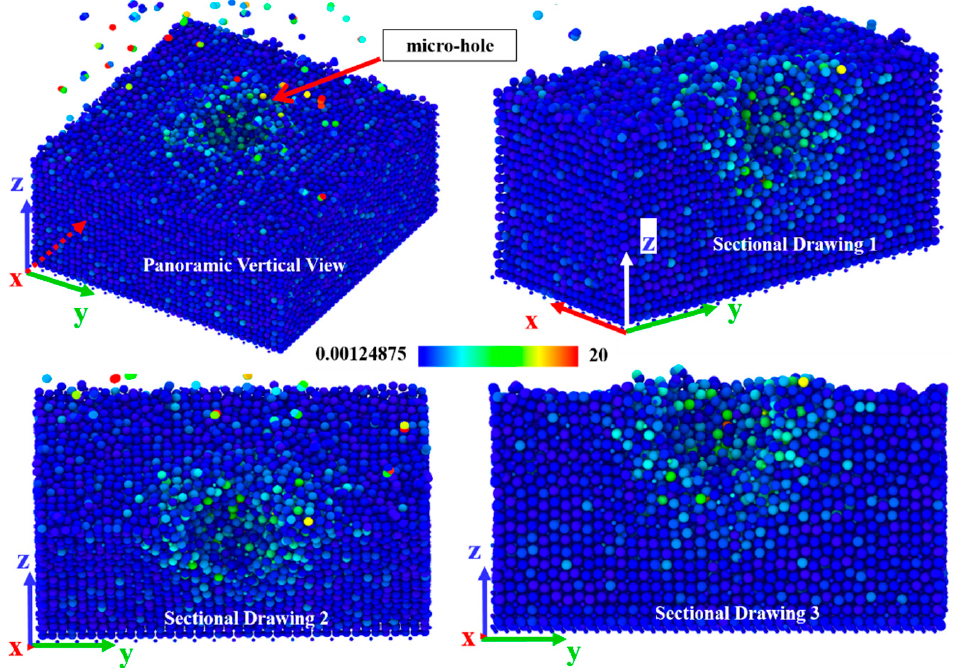
Figure 6. The panoramic vertical view and sectional drawings of structure changes when the abrasive particles have only normal pressure on the surface. When the abrasive particles have both normal pressure and tangential friction on the surface of components, this situation is closer to the real machining process. It is equivalent to the abrasive particles pressing the surface of the element forward and rolling on the surface. At this time, the surface atoms are not only under normal pressure, but also under the action of tangential friction. At the same time, the sub surface atoms will feel the shear stress along the sliding direction, because they are covalently bonded with the outermost atoms. ReaxFF MD simulation shows that at Figure 7, the atoms in the outermost layer have peeled off and bulged (about to peel off), the atomic structure in the bulge has become loose, while the atoms in the sub surface layer have shifted, resulting in the distortion of the original structure. Different from the previous case, at this time, the atomic displacement occurs on both z-axis and x-axis. In this case, micro “scratches” appear on the material